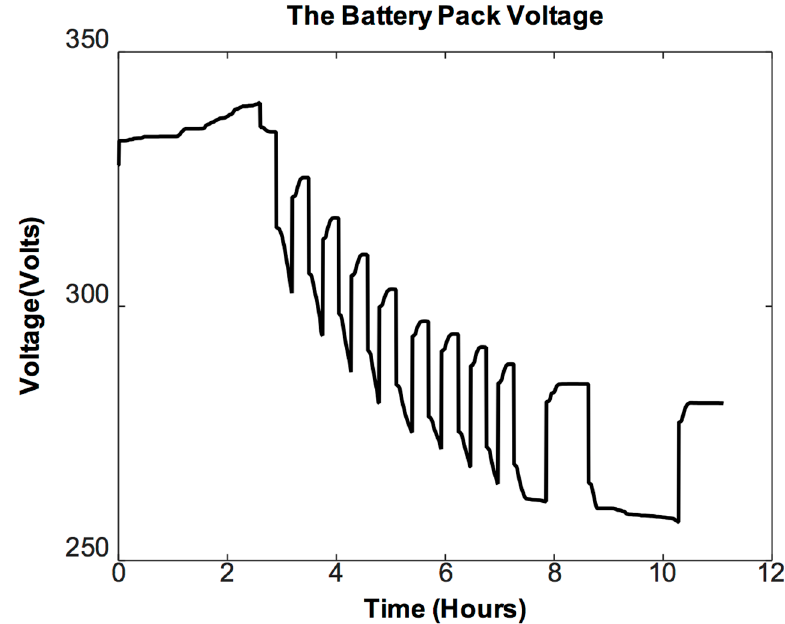
Figure 9. The battery pack voltage.